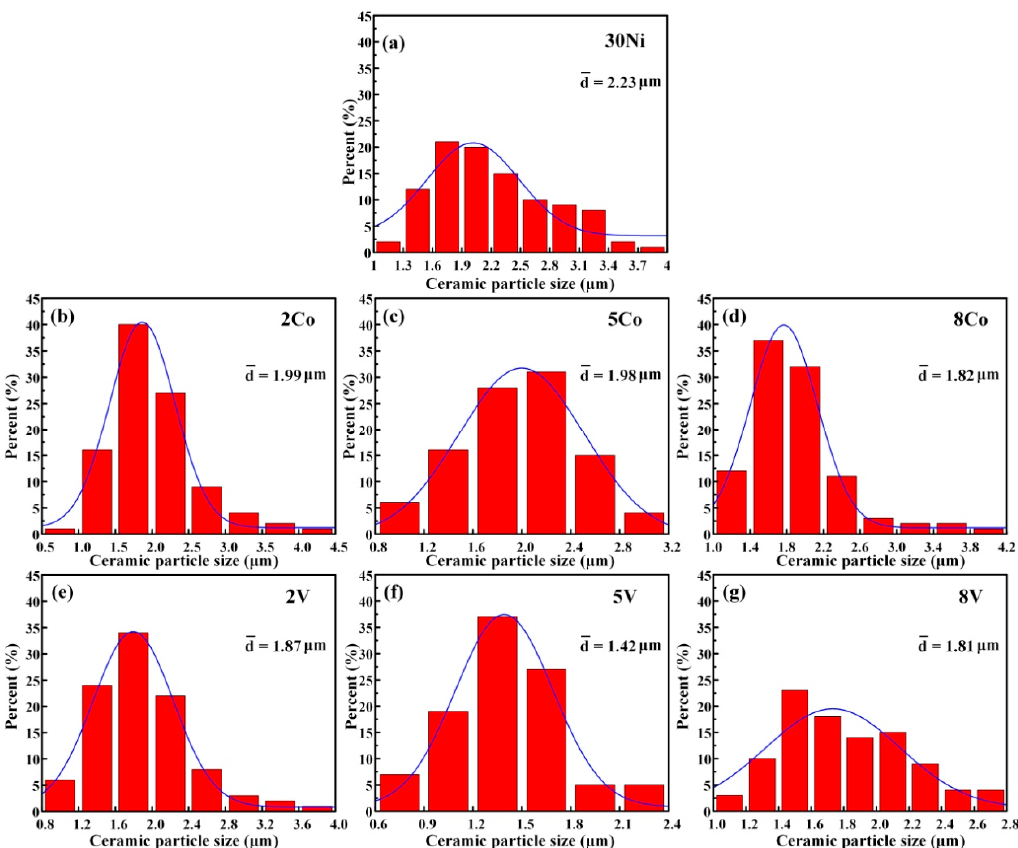
Figure 5. Size distribution diagrams of ceramic particles in the (TiC x N y –TiB 2 )/Ni cermets. ( a ) (TiC x N y – TiB 2 )/Ni cermets with 30 wt.% Ni. ( b – d ) 70 wt.% (TiC x N y –TiB 2 )/Ni cermets with 2, 5 and 8 wt.% Co,